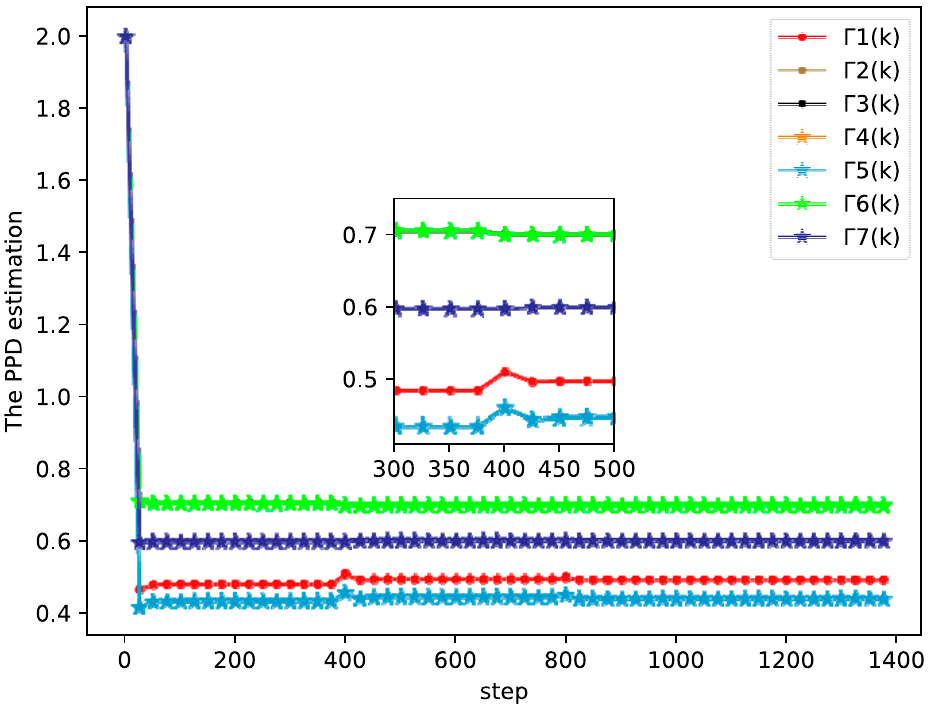
Figure 3. Tracking errors of each agent (example 1).